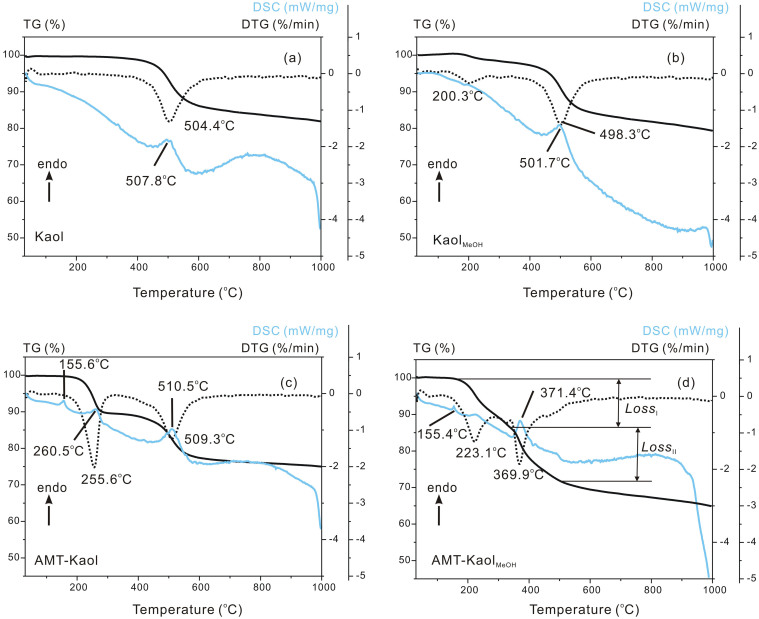
TG, DTG, and DSC curves of (a) Kaol, (b) KaolMeOH, (c) AMT-Kaol, and (d) AMT-KaolMeOH.